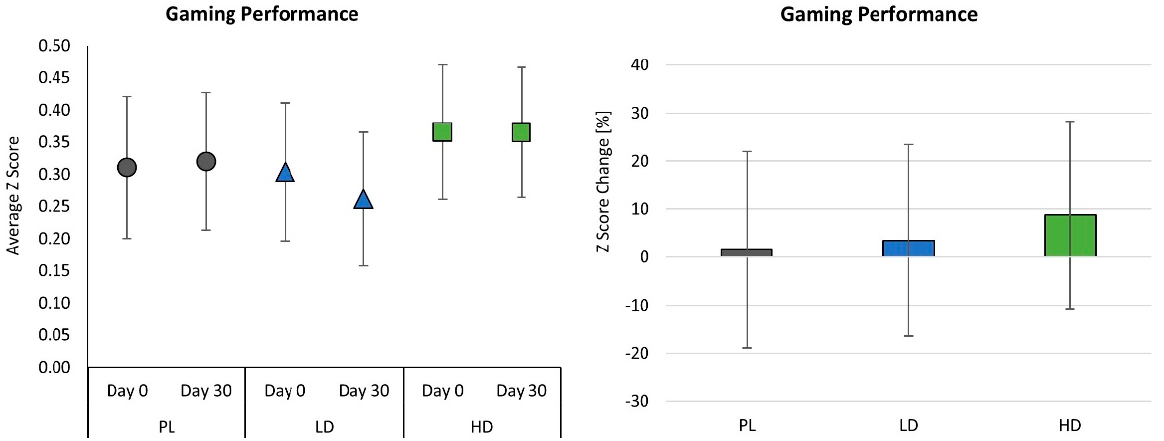
Figure 9. Mean gaming performance Z scores and percent change from baseline with 95% confidence intervals in gaming performance.